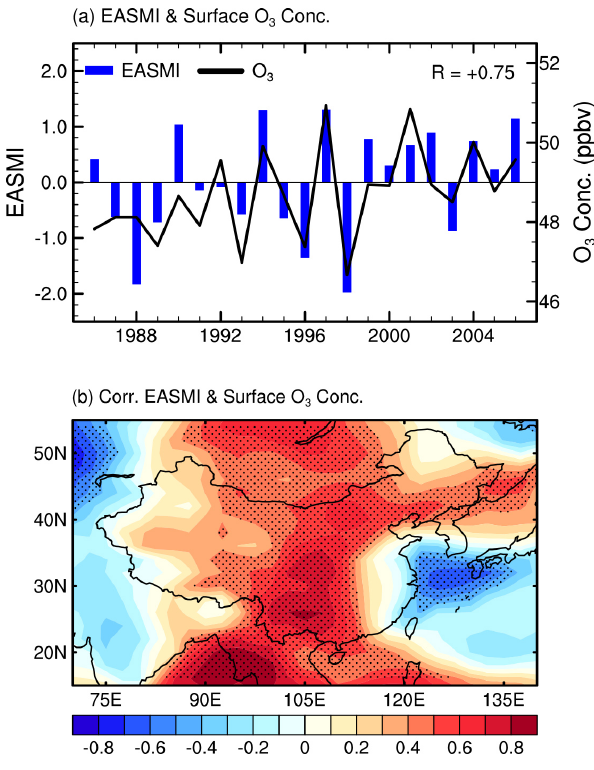
Figure 3. (a) The normalized time series of EASMI (blue bars, left y axis) and the simulated JJA surface-layer O 3 concentrations (black line, right y axis,ppbv) averaged over China for years of 1986–2006. (b) Spatial distribution of the correlation coefficients between the EASMI and the JJA surface-layer O 3 concentrations. The dotted areas indicate statistical significance with 95% confi- dence from a two-tailed Student’s t test. The EASMI are calculated using the GEOS-4 assimilated meteorological